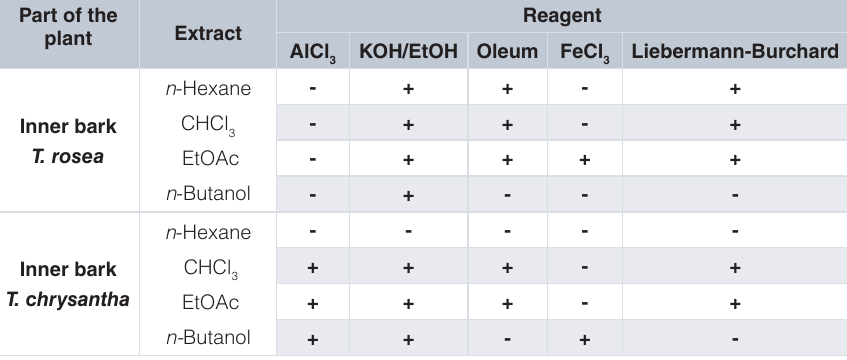
Table 1. Preliminary phytochemical screening of extracts obtained from the inner bark of T. rosea and T. chrysantha